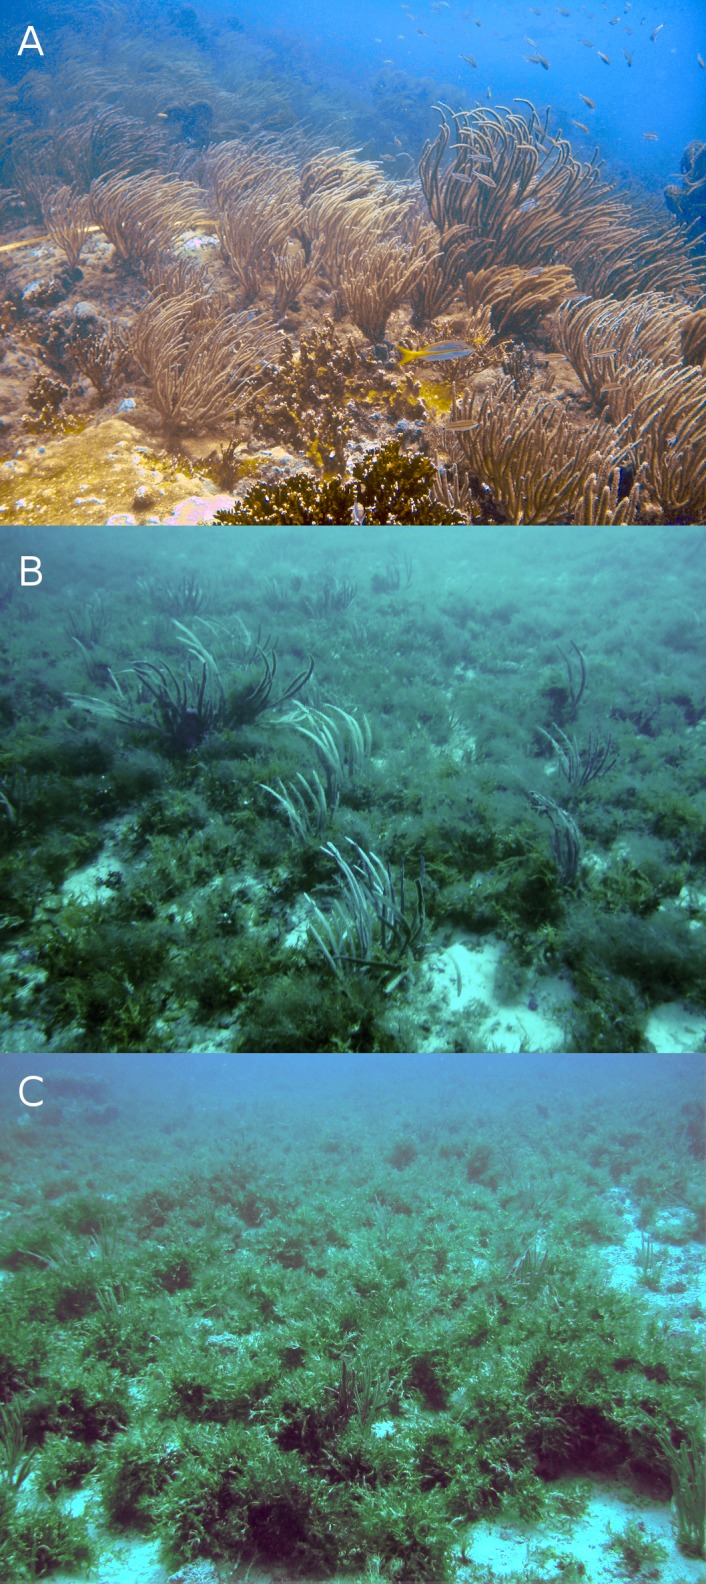
Typical reefscapes of Madagascar reef, Gulf of Mexico: the shallow (depth: 6.8 ± 1.4 m) rocky reef crest (A), and the deeper sandy leeward (14.8 ± 0.16 m) (B) and windward (16.2 ± 2.6 m) (C) regions.